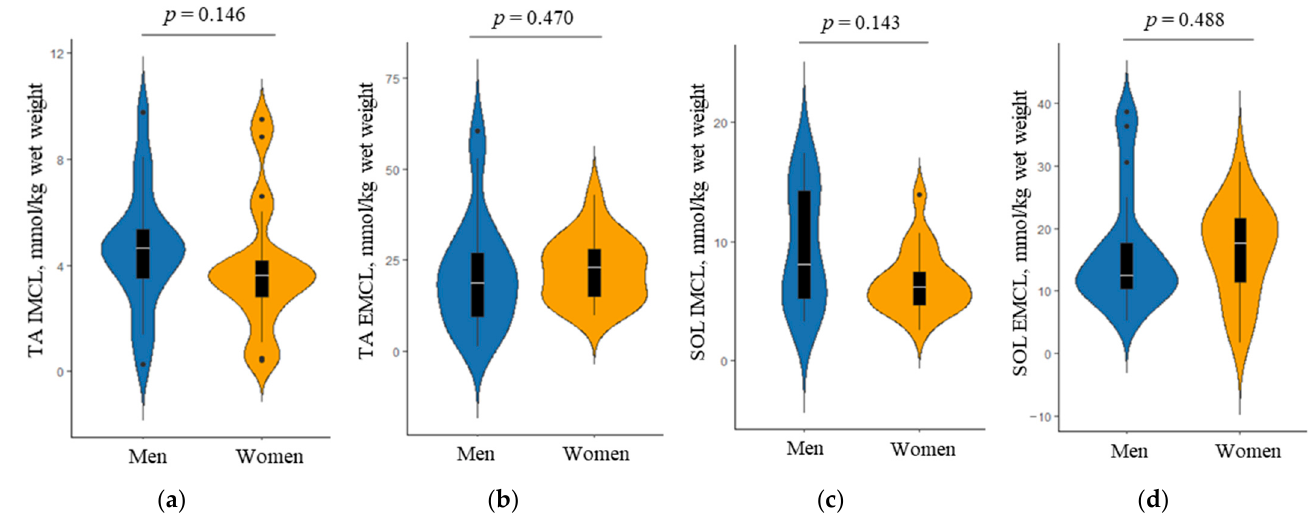
Figure 2. Comparison of the calf cross-sectional area (CSA) as assessed by magnetic resonance imaging between men and women; ( a ) calf muscle CSA, ( b ) calf subcutaneous fat CSA, ( c ) calf intermuscular fat CSA, and ( d ) calf intramuscular fat CSA. The p value was obtained by the Mann–Whitney U test. Violin plots show the distribution of body composition in men and women. Overlaid box plots show medians, interquartile ranges, and spikes extending to the upper- and lower-adjacent values in each group.